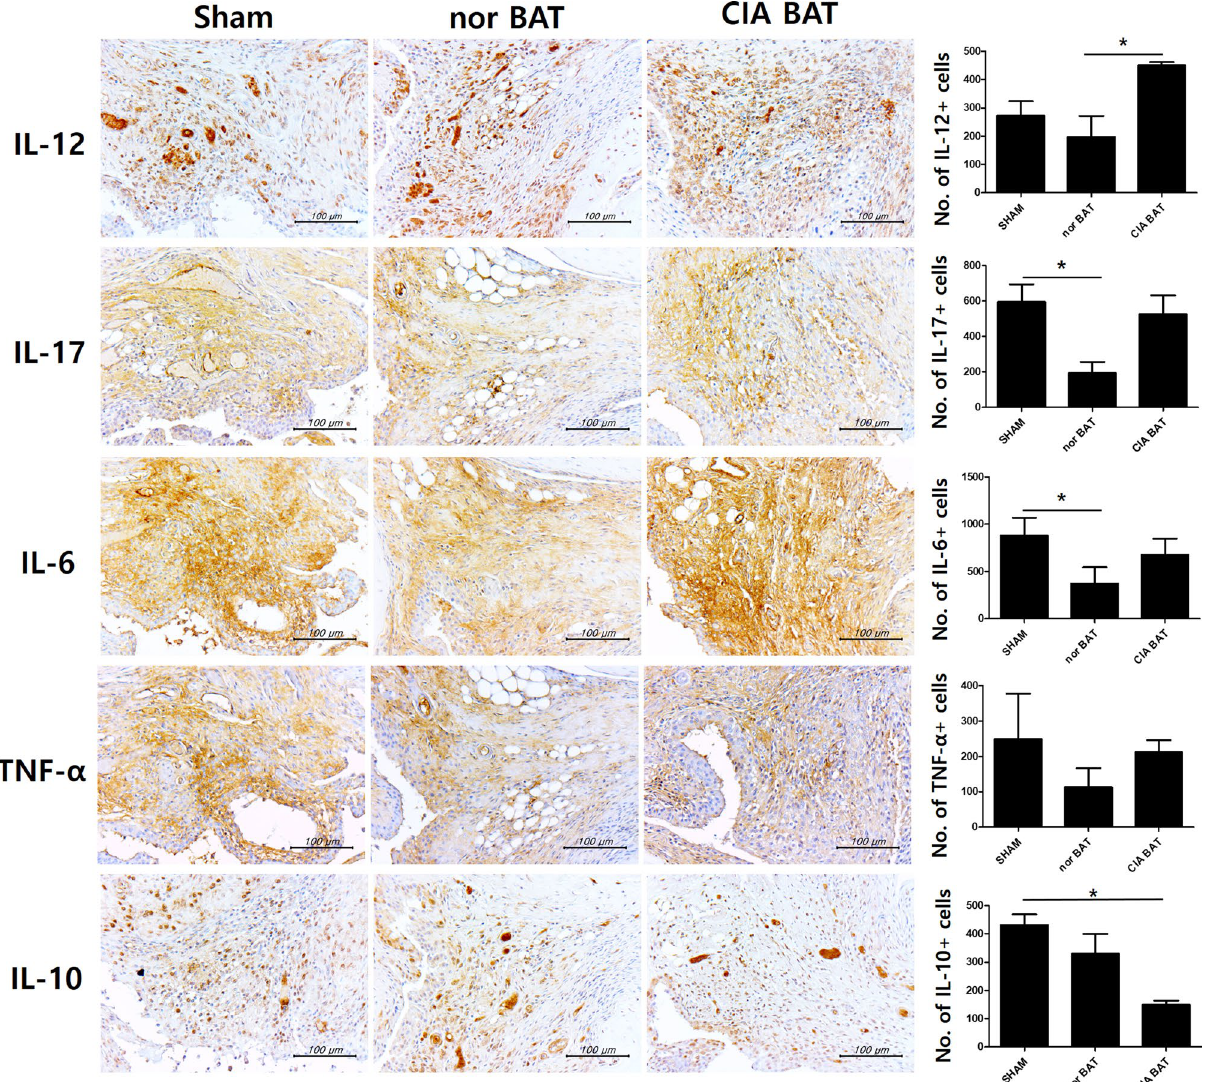
Figure 2. Transplantation of normal brown adipose tissue reduces secretion of proinflammatory cytokines. Immunohistochemistry images are shown with tissues stained by anti-IL-12, anti-IL-17, anti-IL-6, anti-TNF-α, and anti-IL-10 antibodies. *P < 0.05. Scale bars = 100